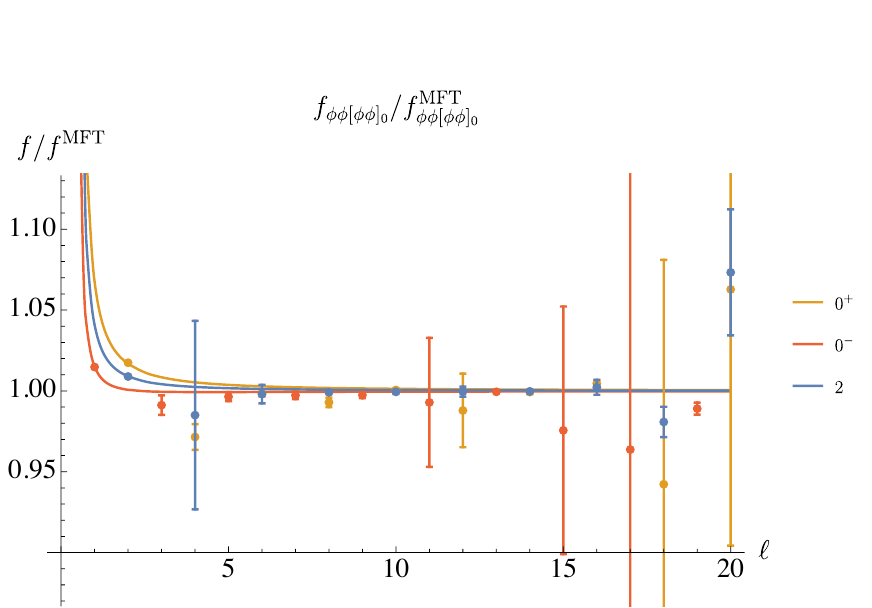
� �� �� Figure 4 . Analytical and numerical predictions for the OPE coe(cid:14)cients of the leading-twist Regge trajectories [ (cid:30)(cid:30) ] 0 (cid:6) ; 2 in the charge sectors 0 (cid:6) ; 2, as a function of spin ‘ . We divide each coe(cid:14)cient 0 by the corresponding coe(cid:14)cient in Mean Field Theory (MFT).